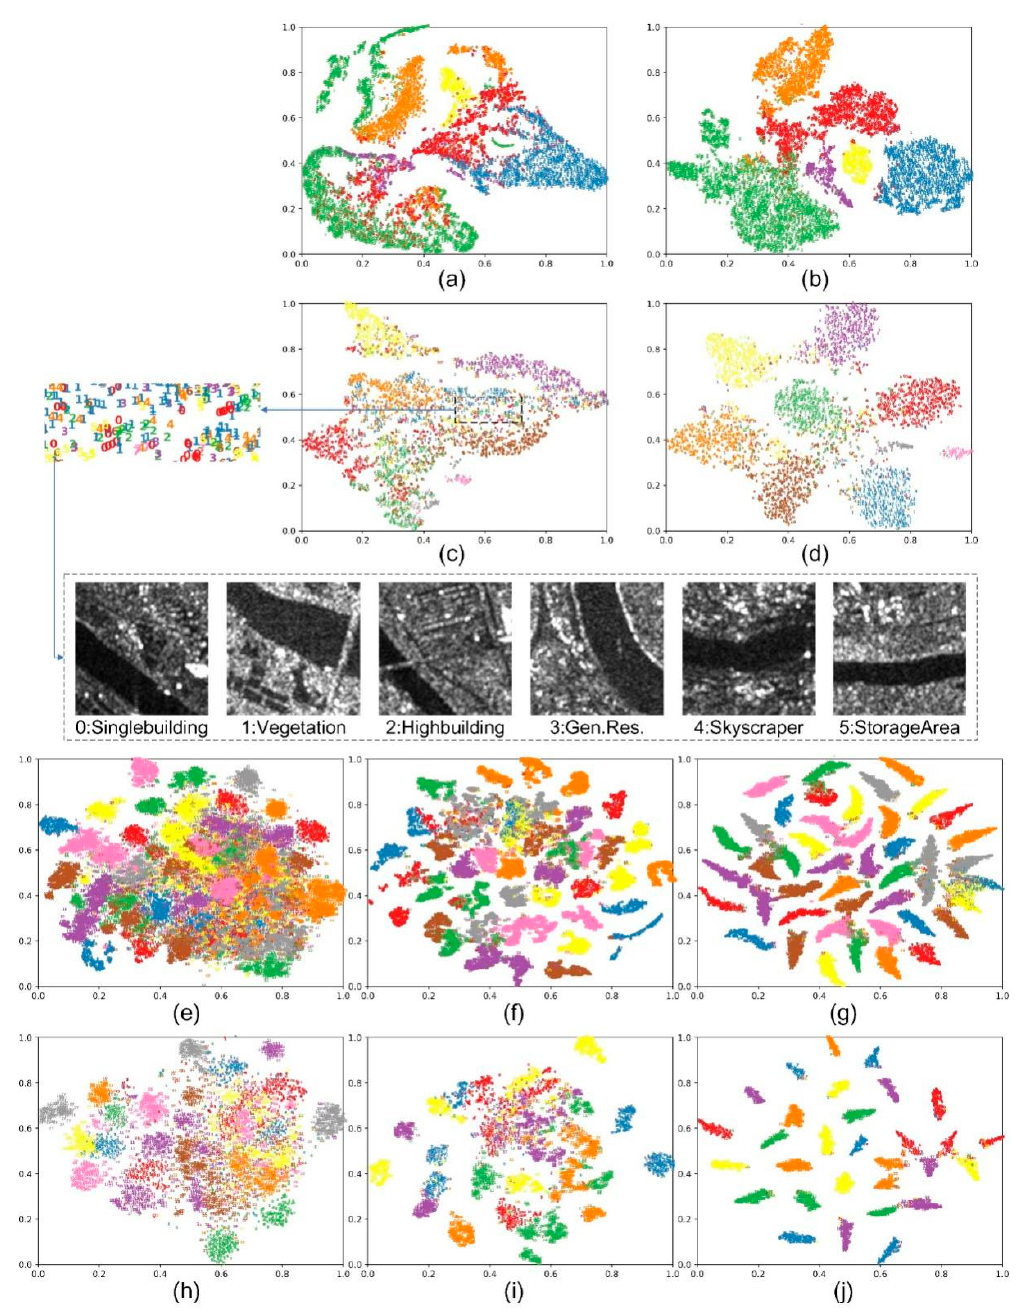
Figure 8. The t-SNE visualization of feature distributions on different datasets. ( a ) Lite-SRL model on WHU-SAR6 dataset; ( b ) fine-tuned Lite-SRL model on WHU-SAR6 dataset; ( c ) Lite-SRL model on OpenSARUrban dataset; ( d ) fine-tuned Lite-SRL model on OpenSARUrban dataset; for SAR dataset due to the imaging mechanism, we did not use ImageNet’s pre-trained model. ( e ) ImageNet pre-trained model on NWPU-45 dataset; ( f ) Lite-SRL model on NWPU-45 dataset; ( g ) fine-tuned Lite-SRL model on NWPU-45 dataset; ( h ) ImageNet pre-trained model on AID dataset; ( i ) Lite-SRL model on AID dataset; ( j ) fine-tuned Lite-SRL model on NWPU-45 dataset.